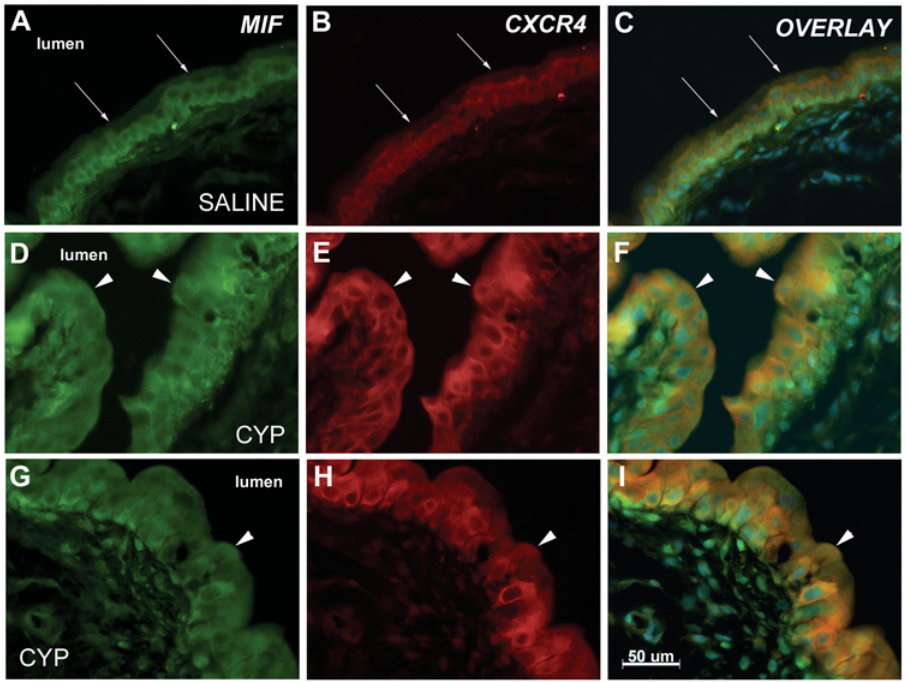
Figure 3. Co-localization of CXCR4 and MIF in urothelium. Representative sections from rats treated with saline (A–C) or CYP (D–I) are shown. The figure shows MIF immunostaining (green immunofluorescence), CXCR4 immunostaining (red immunofluorescence) and an overlay panel combining both immunostaining and a DAPI nuclear stain. MIF immunostaining is seen in basal and intermediate cells and in fibroblasts in the lamina propria of saline treated rats (A), while superficial cells do not stain for MIF. Arrows show luminal edge of urothelium. CXCR4 is restricted to basal and intermediate cells of urothelium (B) and lamina propria is not stained. Overlay of these panels (C) demonstrate co-localization of MIF and CXCR4 as orange coloring of cells. CYP treatment resulted in superficial cell staining for MIF (D,G) and CXCR4 (E,H) and overlay panels (F,I) demonstrate co- localization as orange color in urothelial cells. Arrows point to superficial cells showing MIF-CXCR4 co-localization. Calibration bar=50 m m.